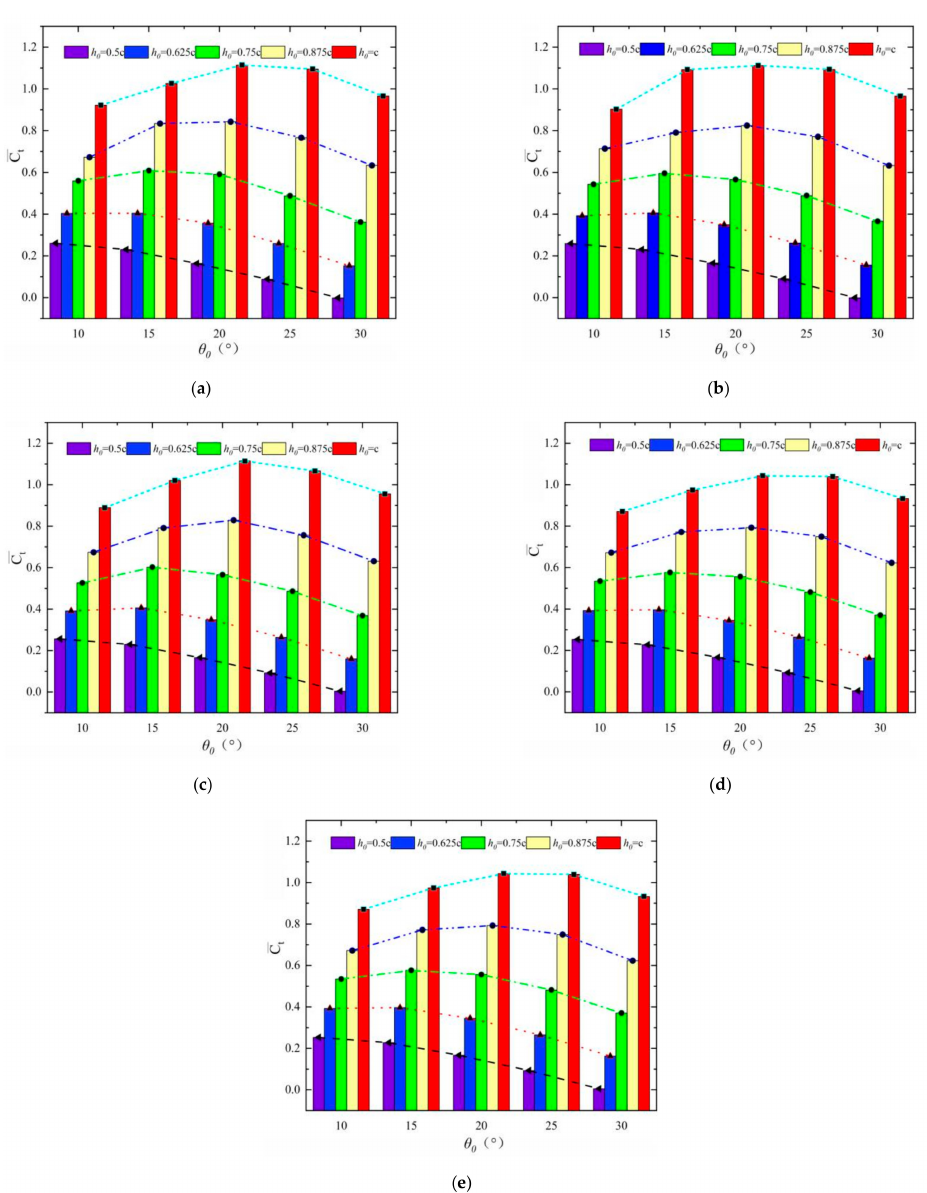
Figure 10. Variation of average thrust coefficient with pitch amplitude under different phase differ- ences and heave motion amplitudes ( a ) ϕ = 60 ◦ ( b ) ϕ = 75 ◦ ( c ) ϕ = 90 ◦ ( d ) ϕ = 105 ◦ ( e ) ϕ = 120 ◦